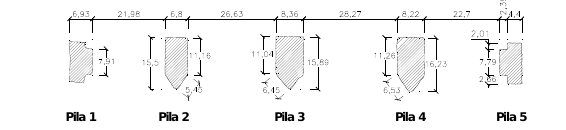
Figure 4. Horizontal sections of the pillars below the start of the arches.